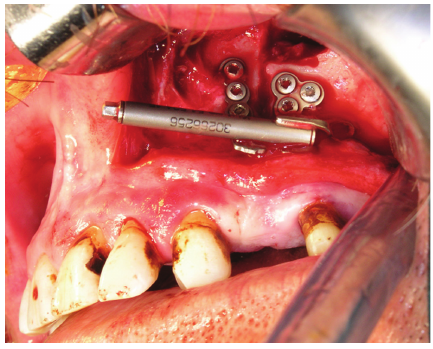
Figure 3: Intraoral view of distractor.